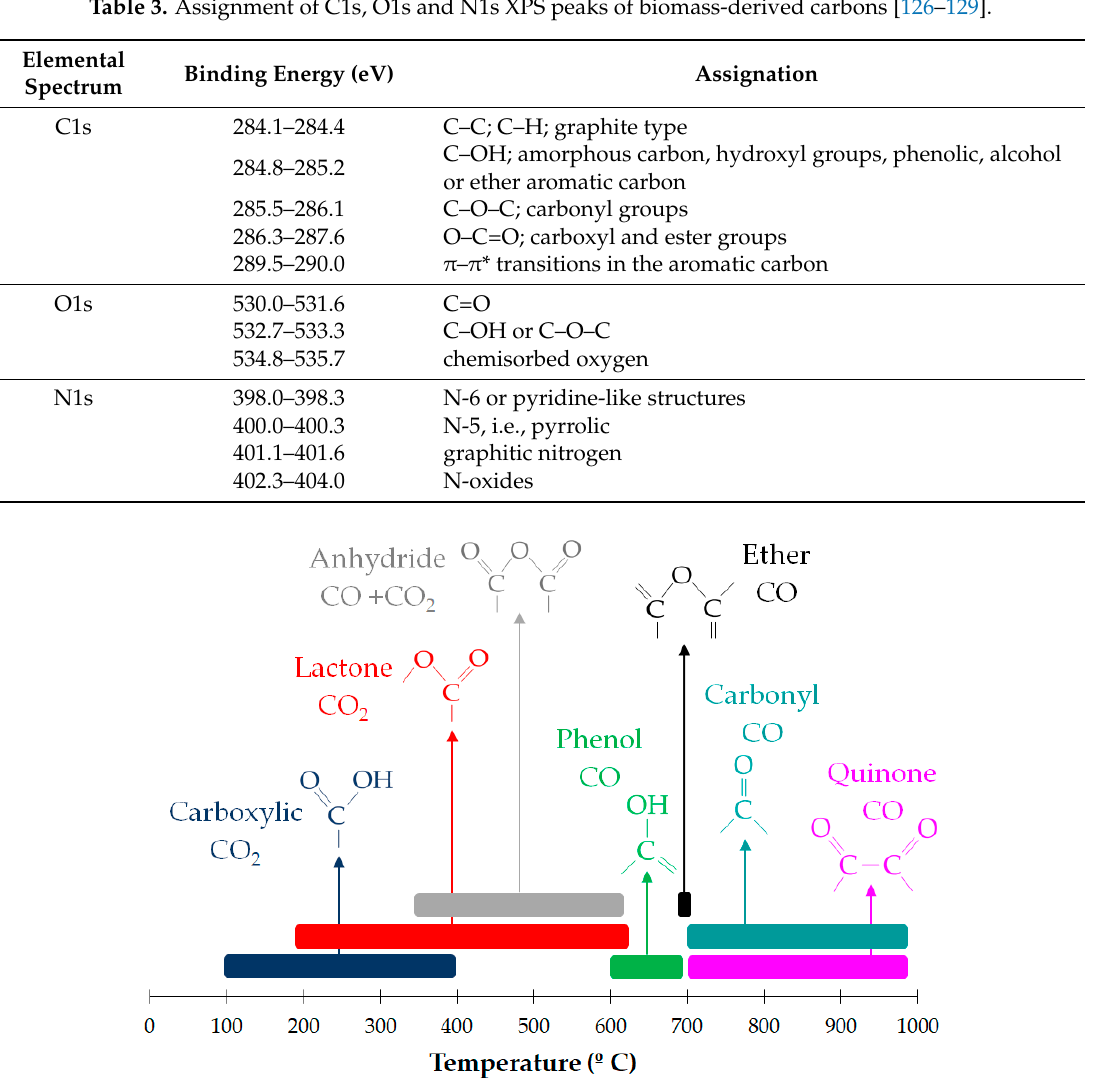
Figure 7. Surface oxygen groups on carbons and their approximate decomposition temperature by temperature programmed desorption (TPD) test.